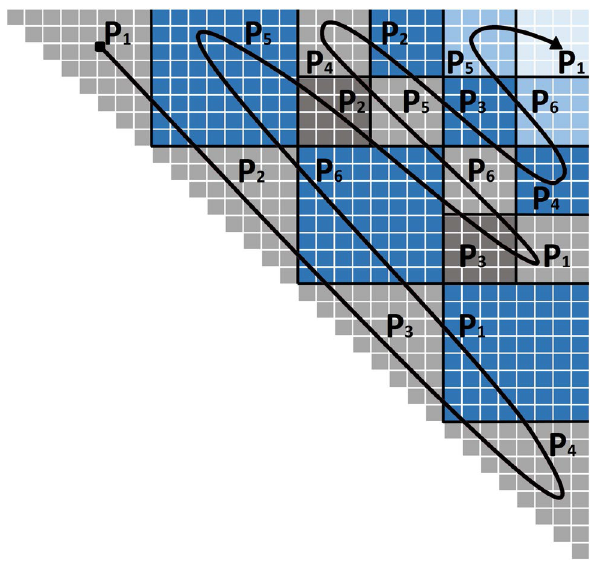
Fig. 8 Snake-like mapping of blocks onto processors for p = 6 , k = 1 and n =